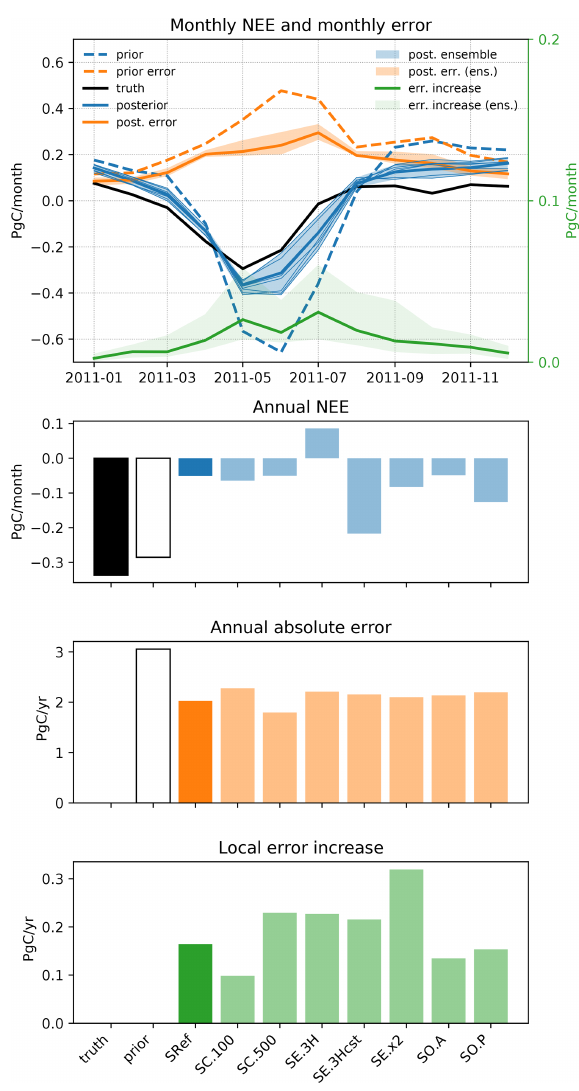
Figure 5. Upper row, left axis: monthly prior NEE (dashed blue line), true NEE (solid black line), posterior NEE (blue), absolute prior error (dashed orange line) and posterior error (orange) in the OSSEs. Upper row, right axis: total error increase (i.e., positive component of the error reduction, green). The SRef inversion is shown as solid lines, and the set of sensitivity tests is shown as a shaded area (prior and posterior ensemble). Second, third and fourth rows: same variables but aggregated